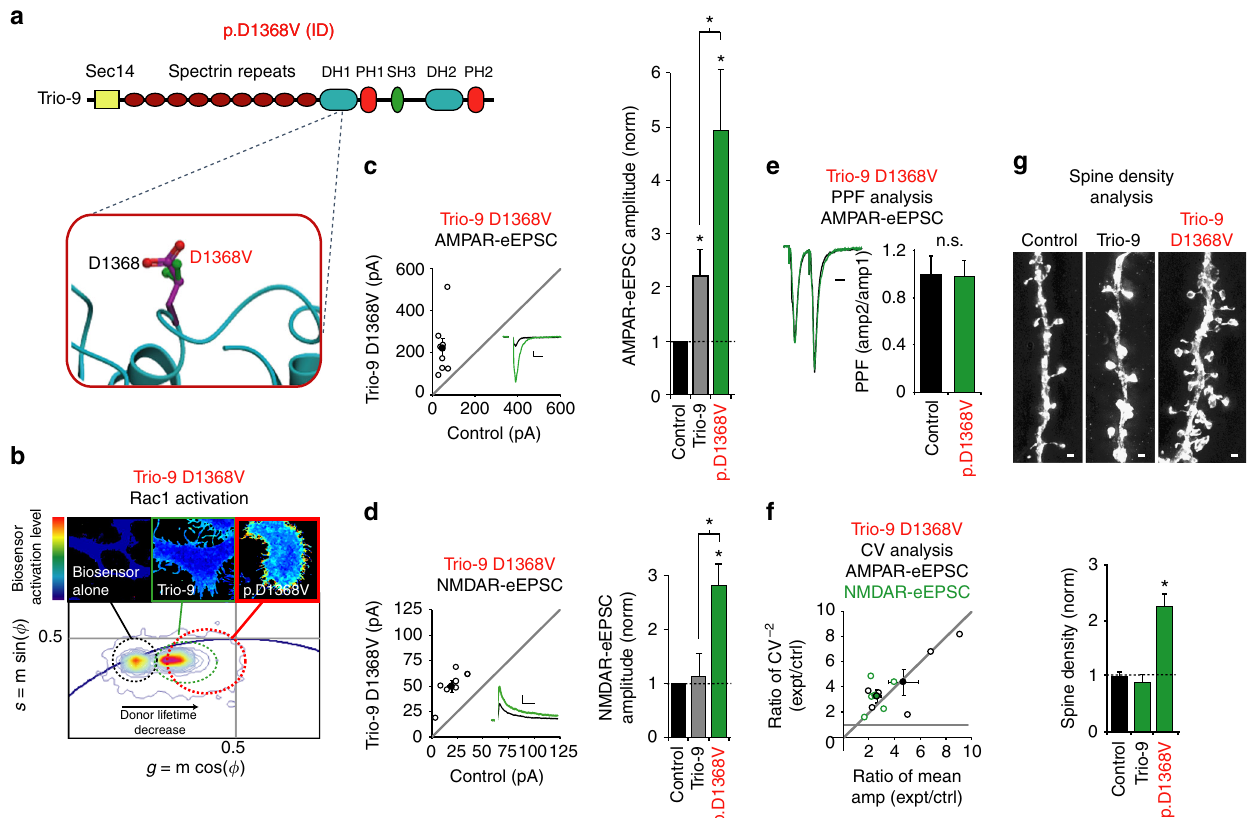
Fig. 7 Trio-9 p.D1368V produces a hyperfunctional synaptogenic form of Trio. a Predicted alteration to Trio ’ s GEF1 domain produced by Trio-9 D1368V. ID, intellectual disability. b Trio-9 D1368V increases Trio-9 ’ s ability to activate Rac1. Representative FLIM color maps of HEK293 cells expressing the Rac1 biosensor alone, the biosensor and Trio-9 D1368V or the biosensor and Trio-9 are shown above. A cropped phasor plot for each condition is shown below. Dashed ovals identify the lifetime distribution for each condition. Complete phasor plots are shown in Supplementary Fig. 2. c , d Scatterplots show amplitudes of eEPSCs for single pairs of control and transfected neurons ( open circles ). Filled circles show mean ± SEM. ( Insets ) Current traces from control ( black ) and transfected ( green ) neurons ( Scale bars : 20 ms for AMPA, 50 ms for NMDA, 20 pA). Bar graphs show the average eEPSC amplitudes ( ± SEM) of neurons expressing Trio-9 (in gray , from Fig. 4j, k) and Trio-9 D1368V normalized to their respective average control eEPSC amplitudes. In the bar graphs a Wilcoxon Rank Sum Test was used to compare across independent conditions (i.e., Trio-9 and Trio-9 D1368V in c , d , *P < 0.05). c Trio-9 D1368V expression increased AMPAR-eEPSC amplitude (* P < 0.05, Wilcoxon Signed Rank Test). d Trio-9 D1368V expression increased NMDAR-eEPSC